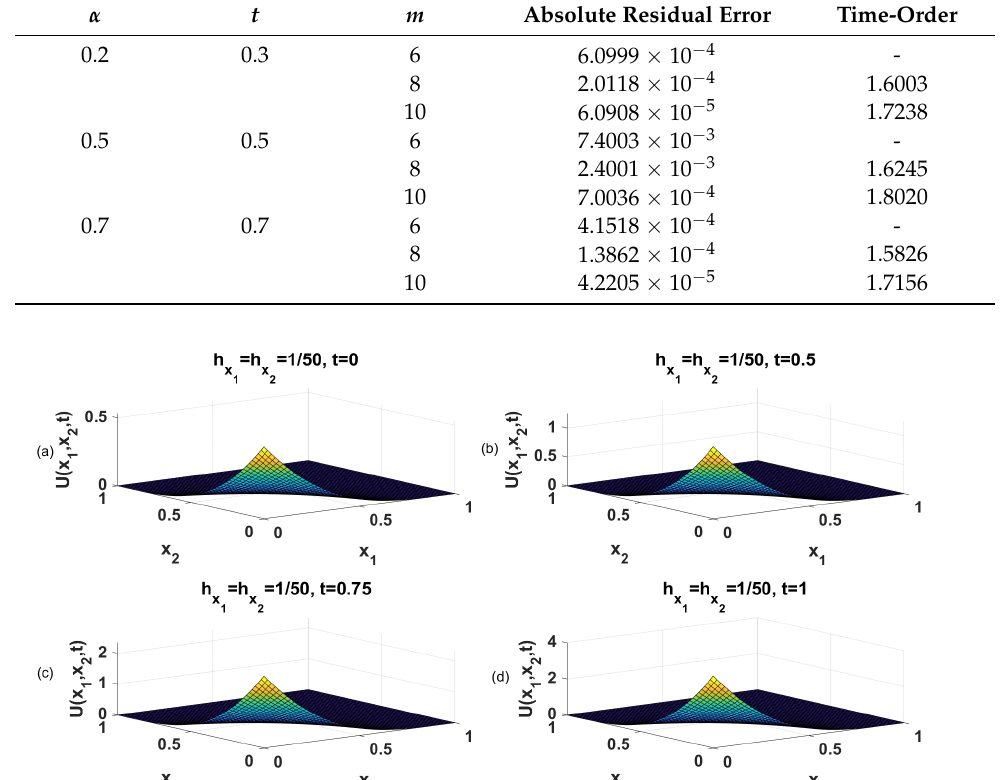
Table 6. The absolute residual error and average convergence order in time-dimension for Example Section 2.1 with x 1 = x 2 = 0.5.